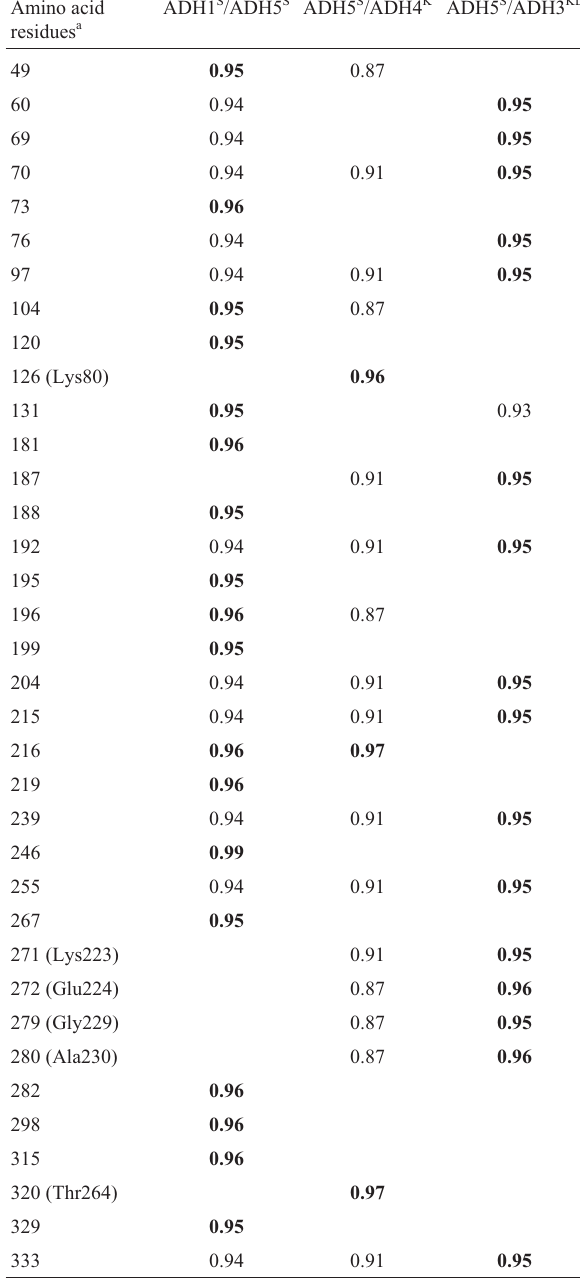
Table 4 - Amino acid residues important for the functional divergence be- tween fungal ADH forms. Amino acid residues a